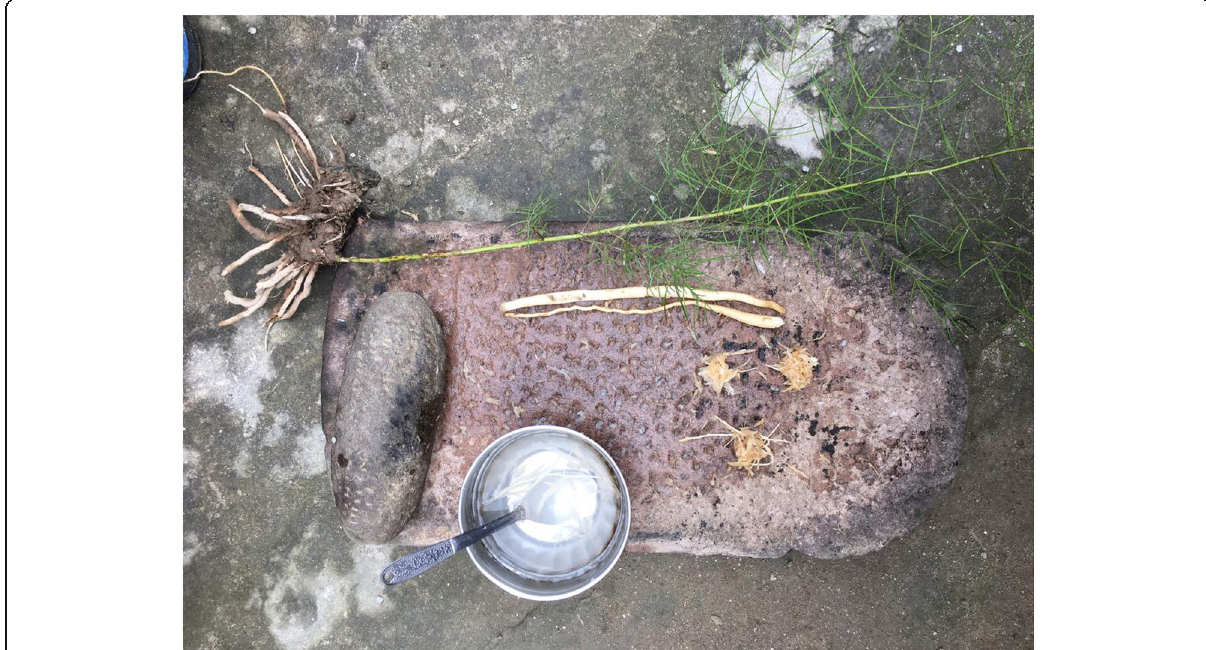
Fig. 1 Fresh roots of Asparagus